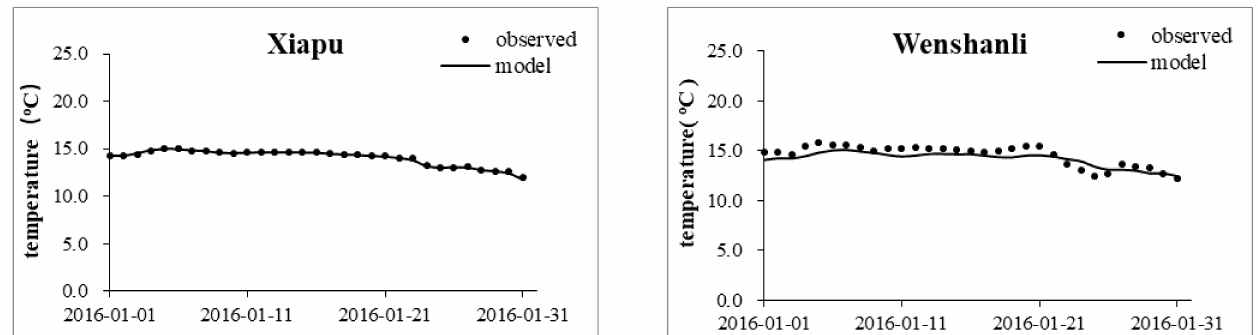
Figure 5. Water temperature calibration results for Xiapu and Wenshanli.